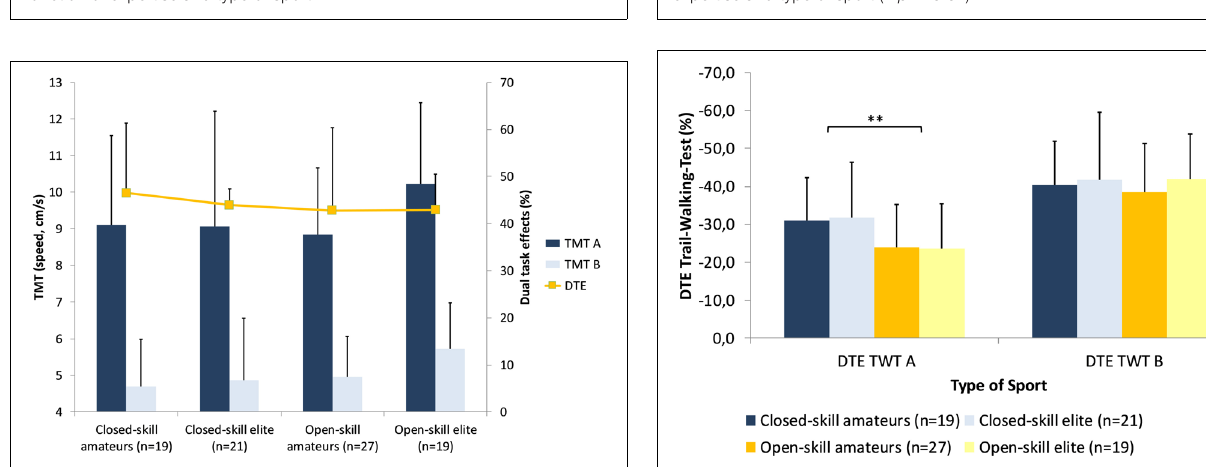
main effect for task difficulty, [ F (1,79) = 4.98, p = 0.028, η 2 = 0.205]. Post hoc p